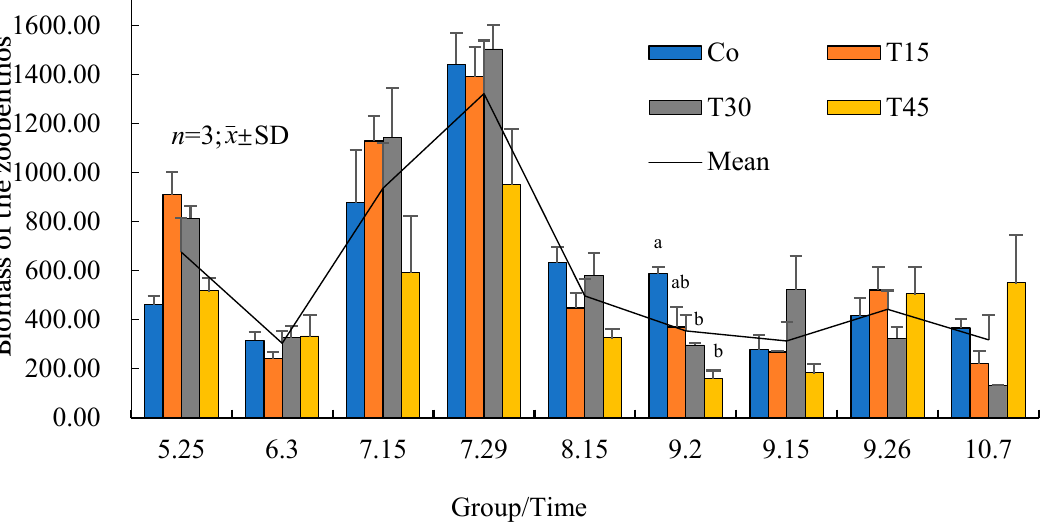
Figure 16. Species and biomass of benthos in different treatment groups during the experiment. The biomass of benthic animals in different treatment groups changed over time.